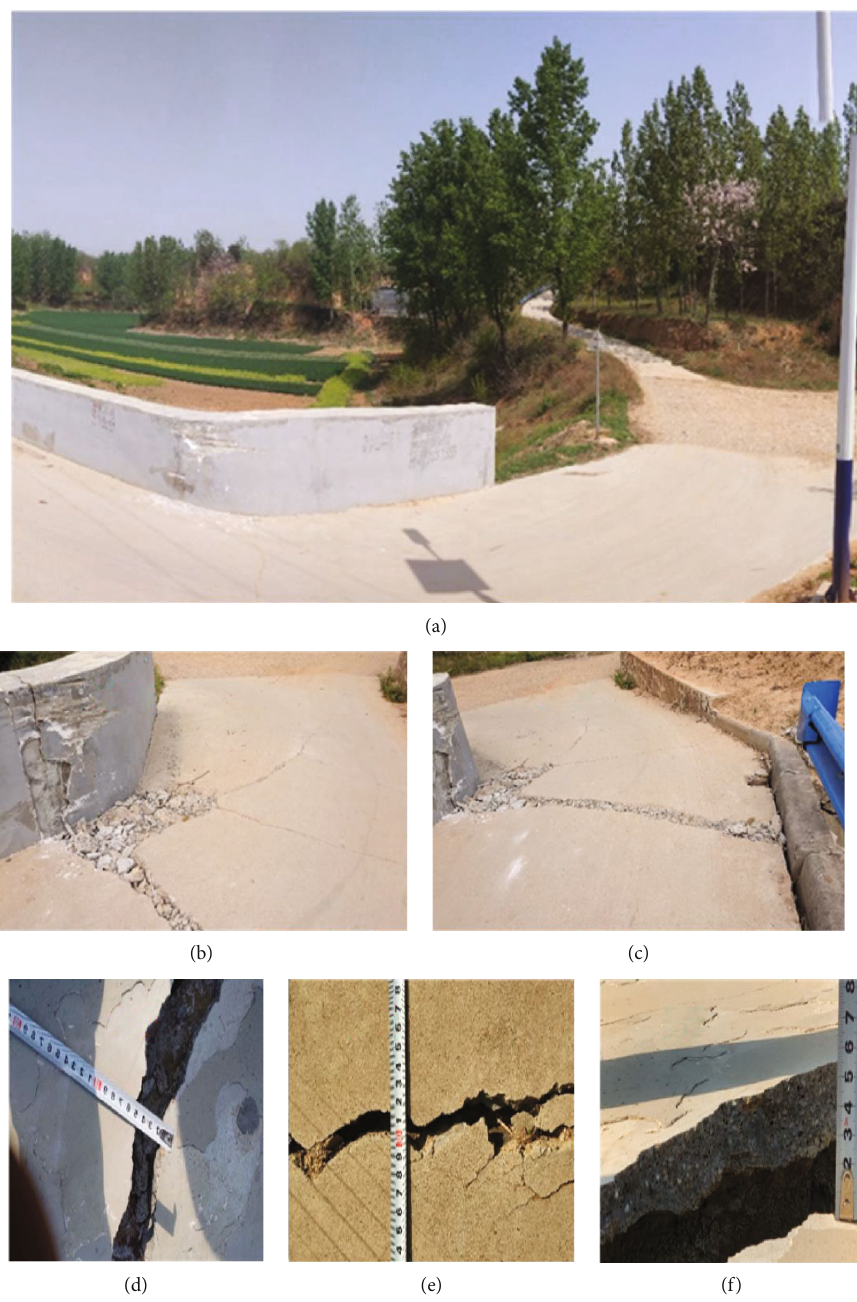
Figure 3: The situation on the east side of the dam. (a) Dam damage in the fi rst phase; (b) and (c) dam damage in the second phase; (d – f) dam damage in the third